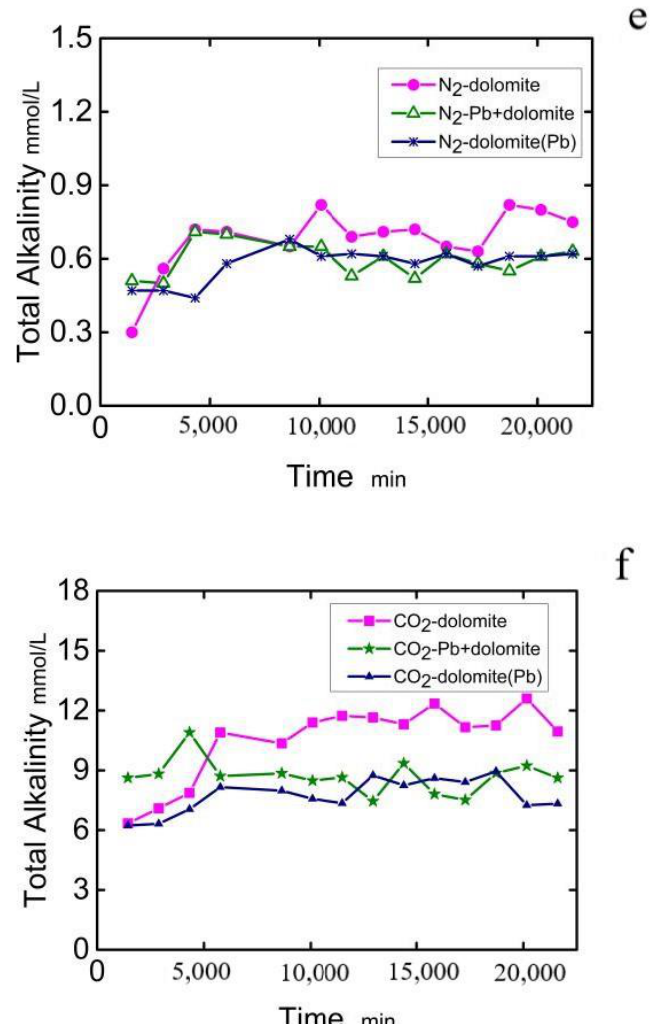
Figure 9. Variations in the pH, conductivity, and total alkalinity of different systems during 15 days of reaction. ( a ) Electrical conductivity in nitrogen atmosphere; ( b ) Electrical conductivity in carbon dioxide atmosphere; ( c ) pH in nitrogen atmosphere; ( d ) pH in carbon dioxide atmosphere; ( e ) TIC in nitrogen atmosphere; ( f ) TIC in carbon dioxide atmosphere.